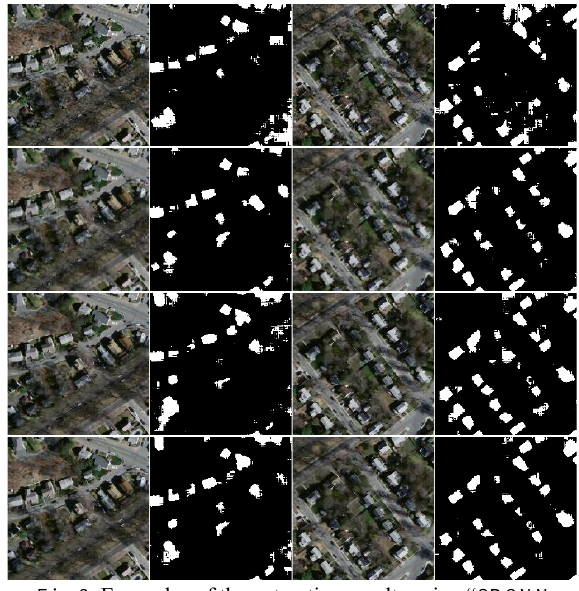
Fig. 3. Examples of the extraction results using “SRCNN- HRNet v2”